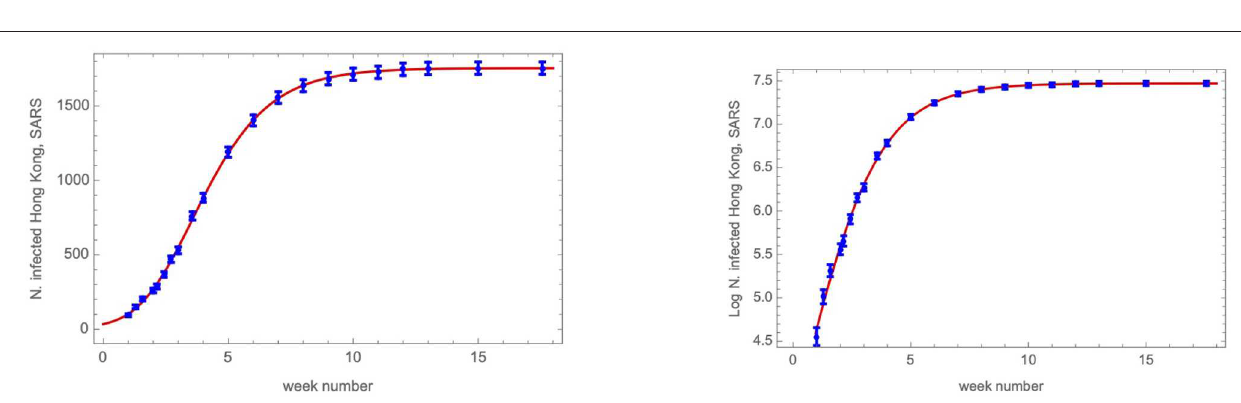
FIGURE 2 | (Left) SARS-2003 infected cases in Hong Kong as function of the week number starting from March 17 2003. In red, we report the exponential of the epidemic strength model result. (Right) Epidemic strength (the logarithm of the number of infected cases) and the best fit result as in Equation (4).